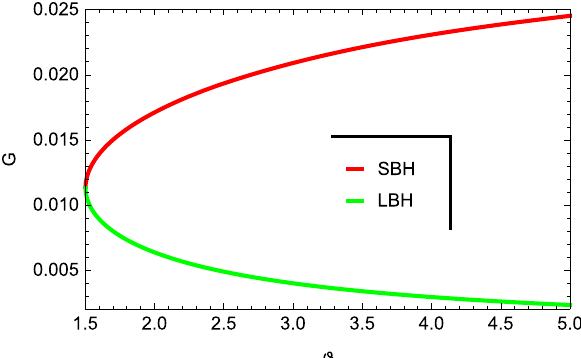
Fig. 15 PlotoftheGibbsfreeenergy G intermof ϑ for P = 0 . 04 , ζ = 0 . 1 and (cid:20) = 0 . 9